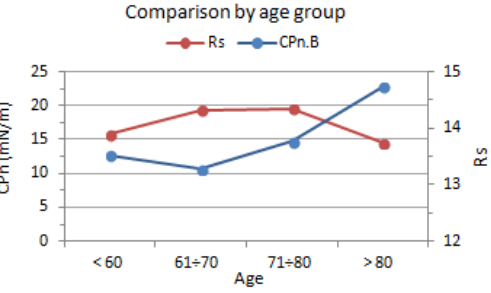
Figure 6. Influence of age group on skin